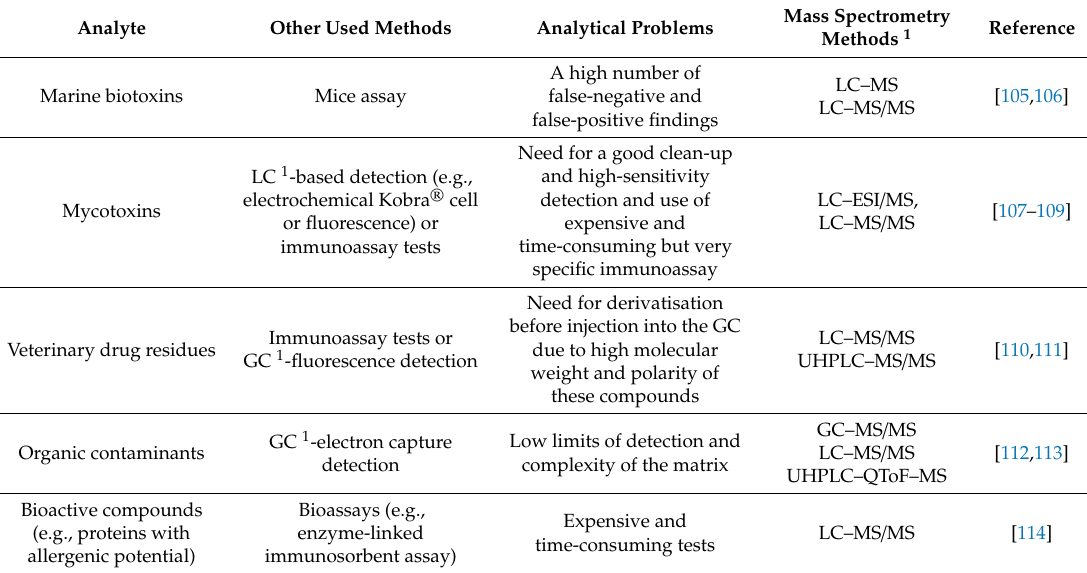
Table 3. Use of high-resolution MS in several agri-food